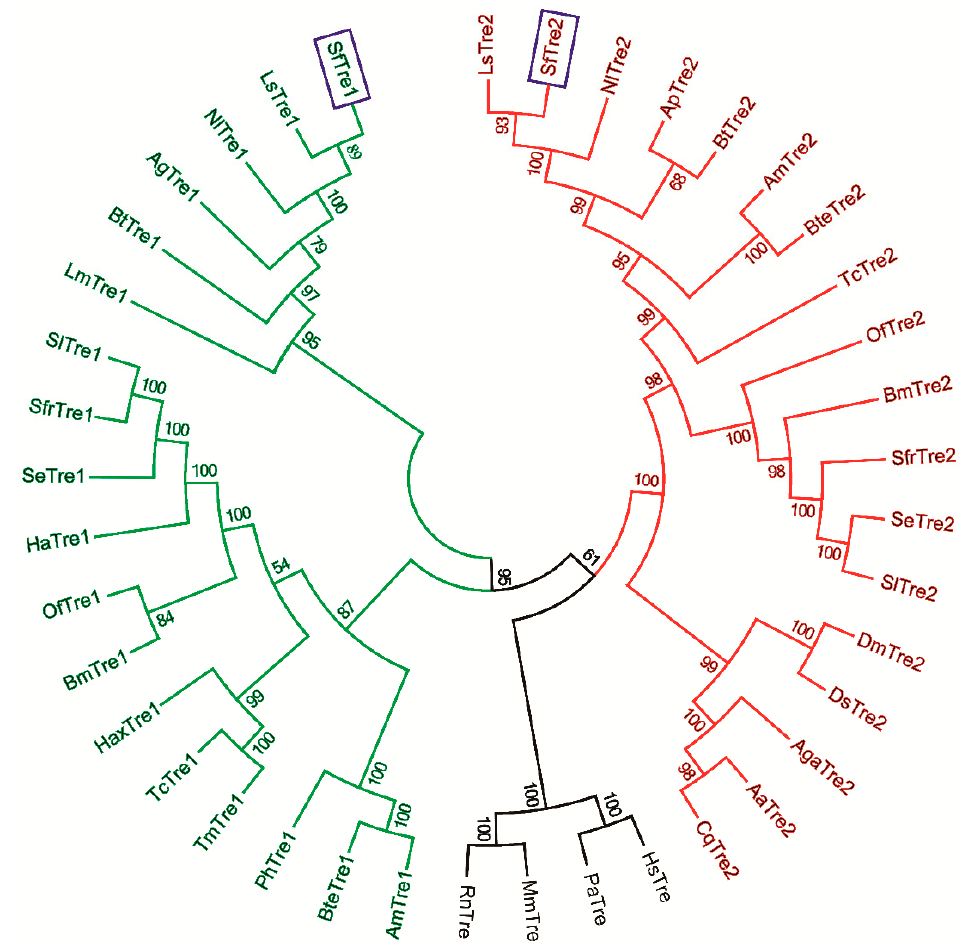
Figure 3. Phylogenetic tree of Tres in insects and other organisms. Organisms with the